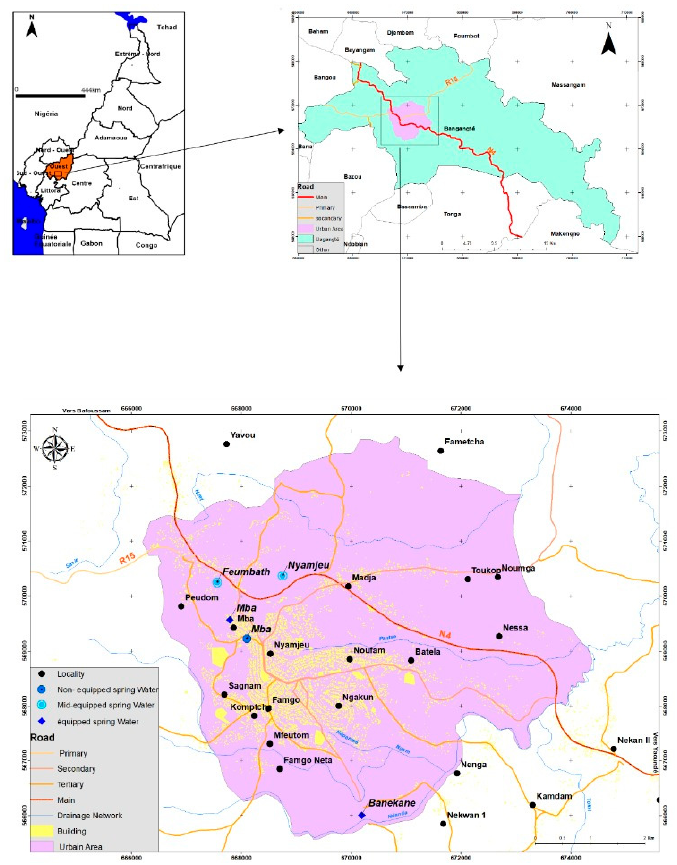
Figure 1. Location of the city of Bangangté in Cameroon.